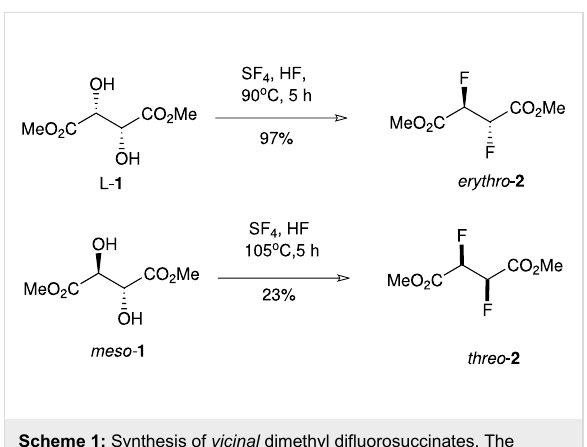
Scheme 1: Synthesis of vicinal dimethyl difluorosuccinates. The conversion of the tartrates 1 with SF 4 and HF [6,7].